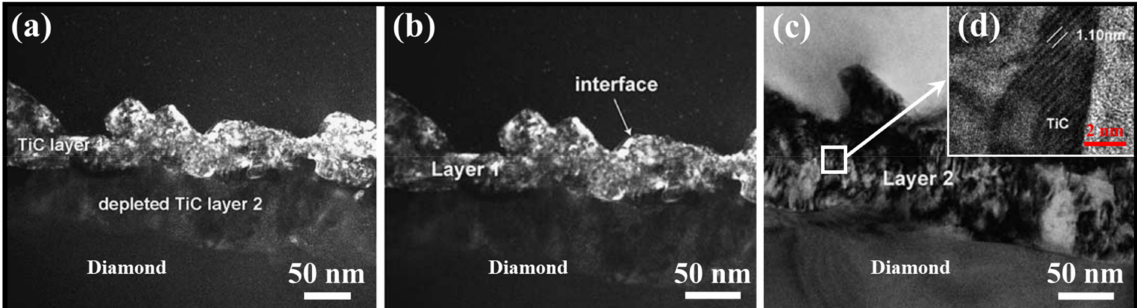
Figure 13. TEM micrographs showing two thin TiC layers formed at the diamond/metal matrix interface in the tilting experiment: ( a ) two thin TiC layers, ( b ) columnar TiC (layer 1), ( c ) nano-sized TiC (layer 2), ( d ) nano-sized TiC (1.10 nm). Reprinted with permission from Ref. [18]. Copyright 2004,